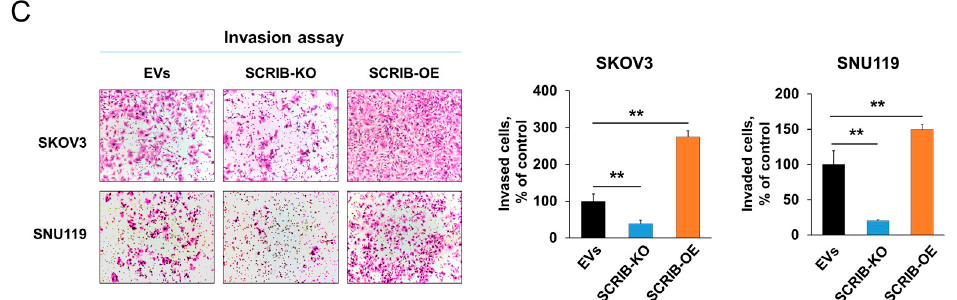
Figure 6. The effect of SCRIB on the invasiveness of ovarian carcinoma cells. ( A ) A wound healing assay was performed three times with SKOV3 and SNU119 cells transfected with empty vector, vector for knockout of SCRIB , or a SCRIB overexpression vector. EVs; the cells transfected with both empty vector for knockout and empty vector for overexpression of SCRIB. Microscopic images for wound healing assay were taken just after making linear scratches and again at 24 h after making scratches. The wound width was measured from the microscopic images and presented as ‘% of control’. The values in graphs are presented as the mean ± standard deviation. ( B ) The trans-chamber migration assay was performed by growing 5 × 10 4 SKOV3 or 1 × 10 5 SNU119 cells in the upper chamber for 48 h. ( C ) The trans-chamber invasion assay was performed by growing 1 × 10 5 SKOV3 or 2 × 10 5 SNU119 cells in the upper chamber with Matrigel for 48 h. The number of migrated or invaded cells were counted in five ×100 microscopic fields in each well. ** p < 0.001.